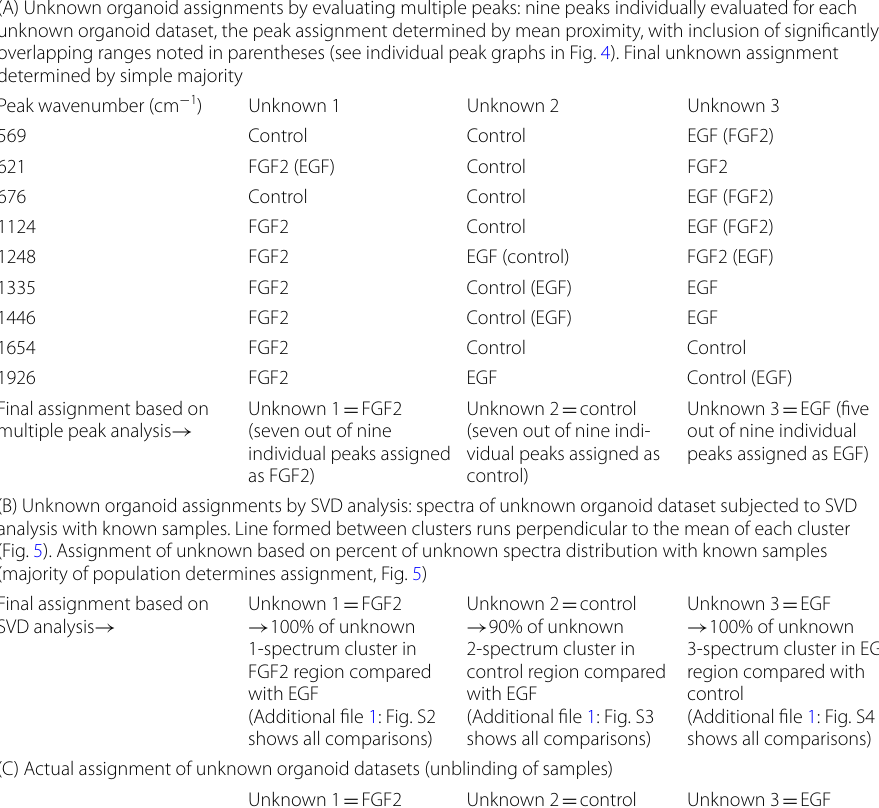
(Fig. 5). Assignment of unknown based on percent of unknown spectra distribution with known samples (majority of population determines assignment, Fig. 5) Final assignment based on SVD